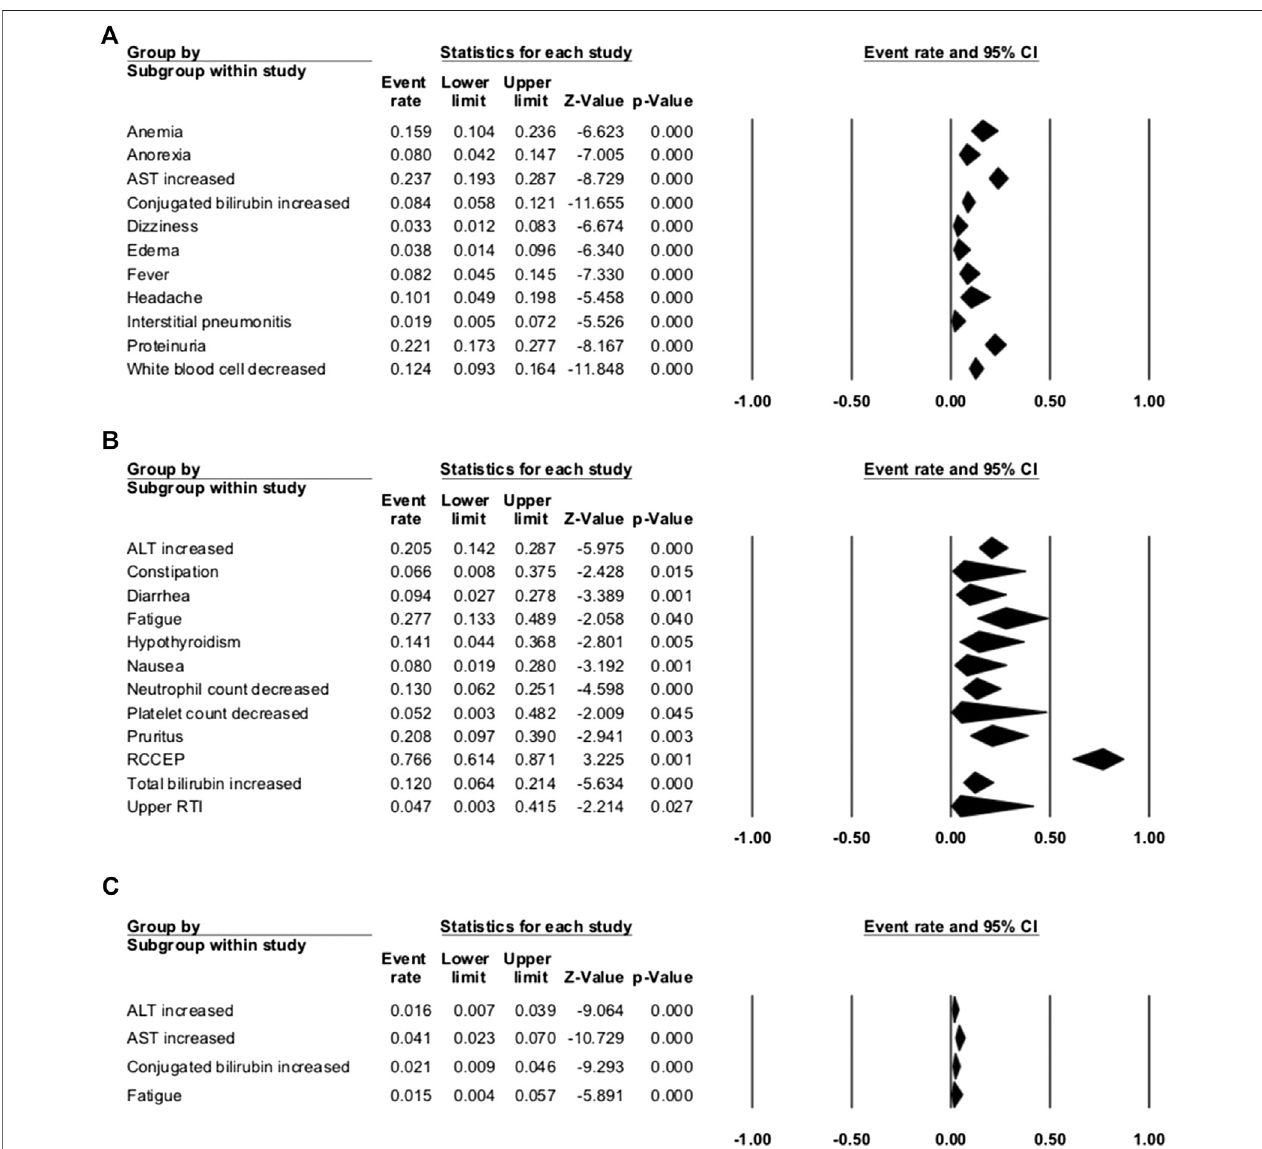
FIGURE 2 | Adverse events (AEs) of camrelizumab alone. (A) The fi xed model of all-grade AEs; (B) the random model of all-grade AEs; and (C) the fi xed model of grade ≥ 3 AEs.